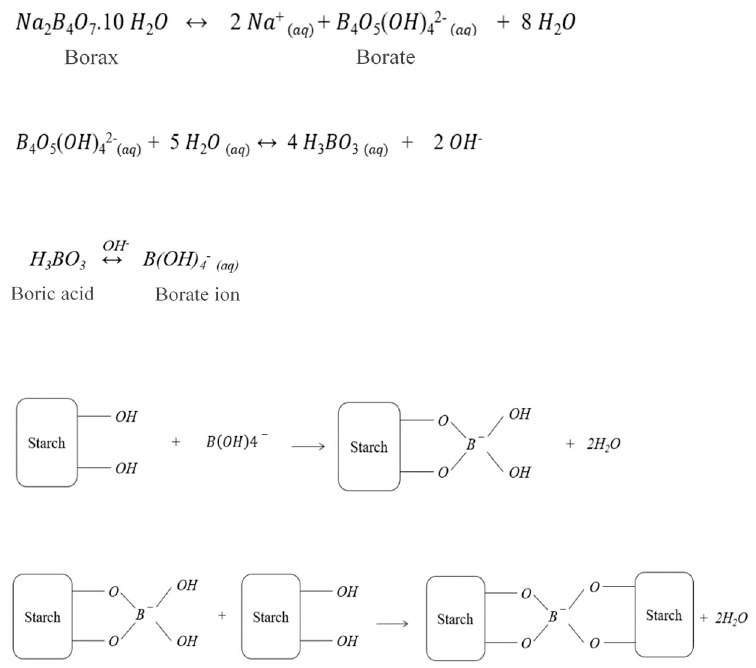
Figure 12. The dissociation of borax in water and the proposed mechanism between boric acid / borax and starch.